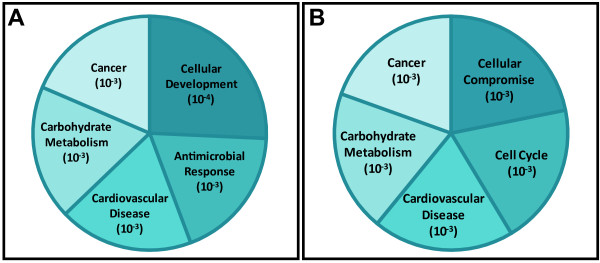
Biological functions enriched in molecular networks altered in TK6 cells exposed to arsenic or cadmium. The five most significantly enriched biological functions within the (A) arsenic or (B) cadmium-induced molecular networks are illustrated.